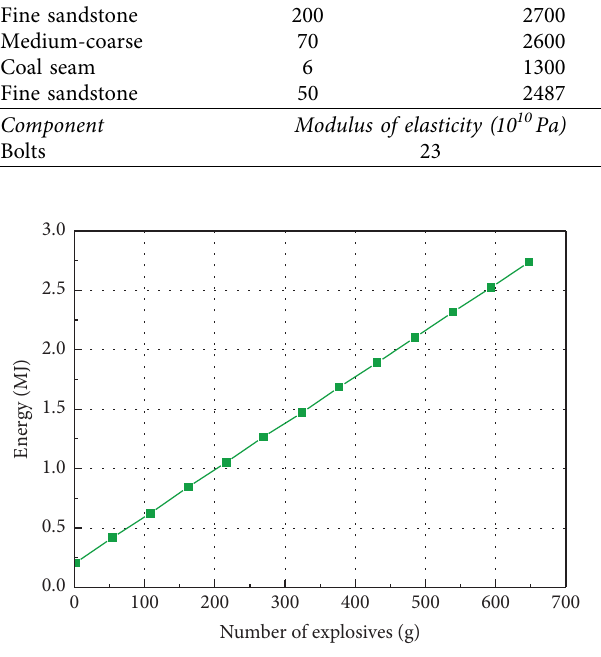
Figure 3: Relationship between explosive quantity and energy.